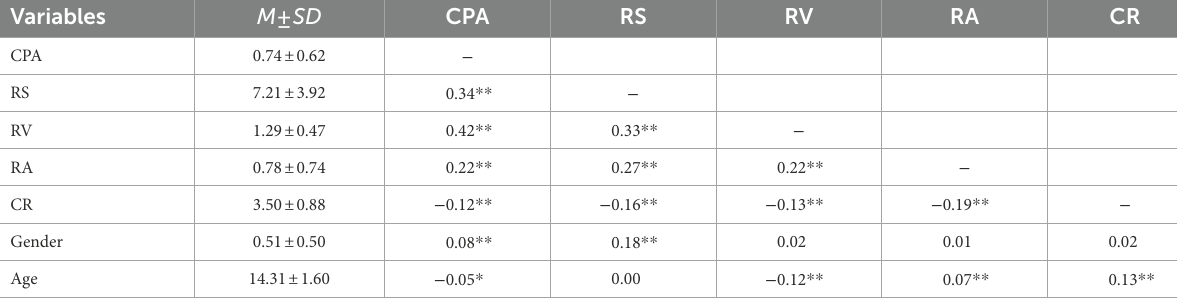
TABLE 2 Descriptive statistics of model variables and correlations among model variables.